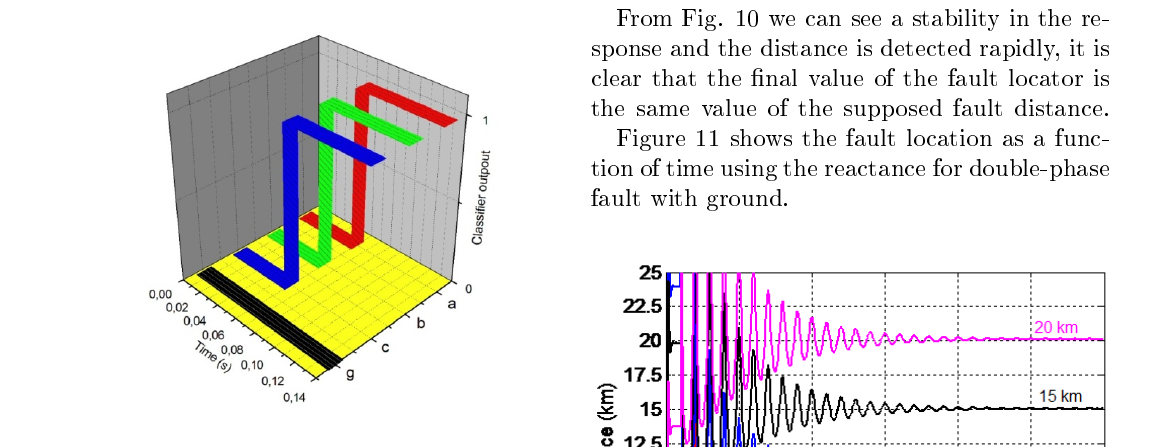
Fig. 9: Fault classi(cid:28)er output forthe three-phase fault’a’, ’b’, and ’c’.